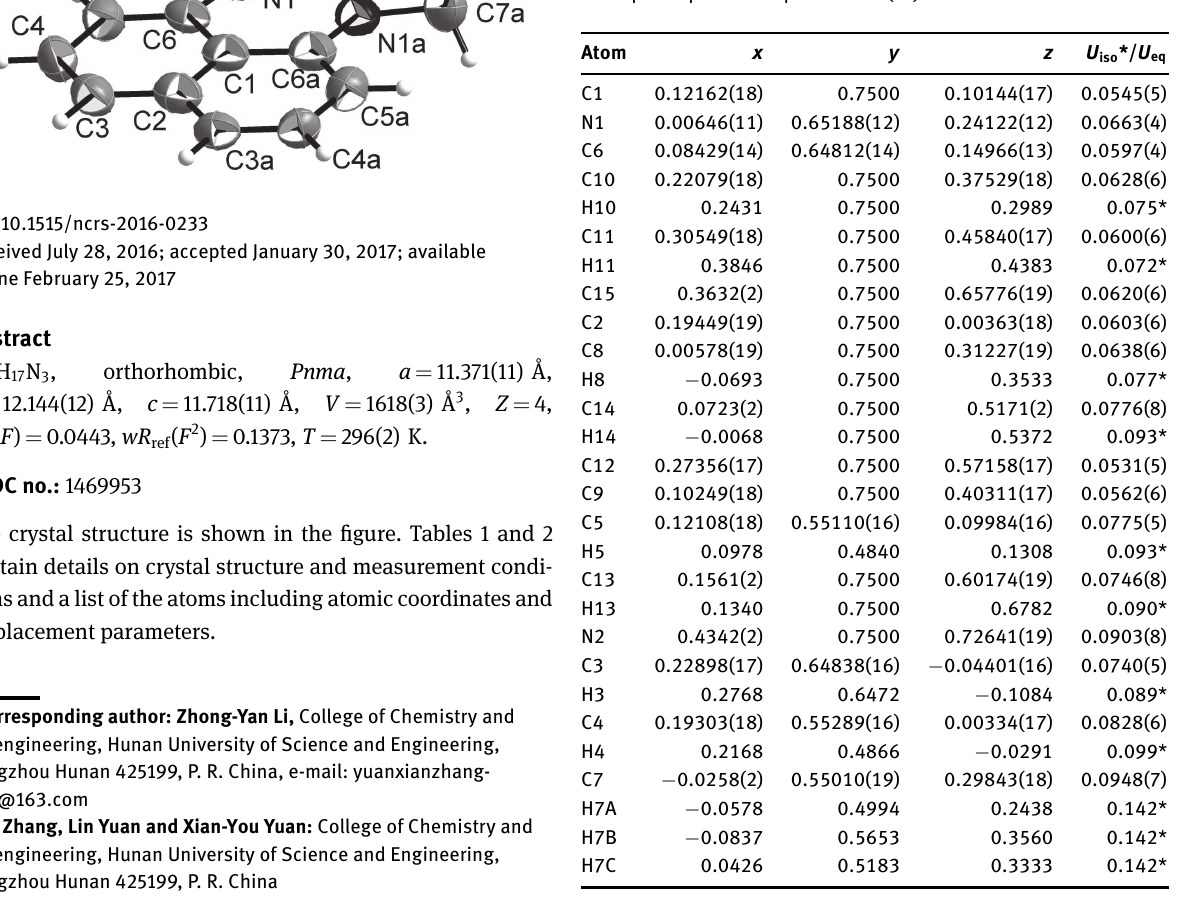
Table 2: Fractional atomic coordinates and isotropic or equivalent isotropic displacement parameters (Å 2